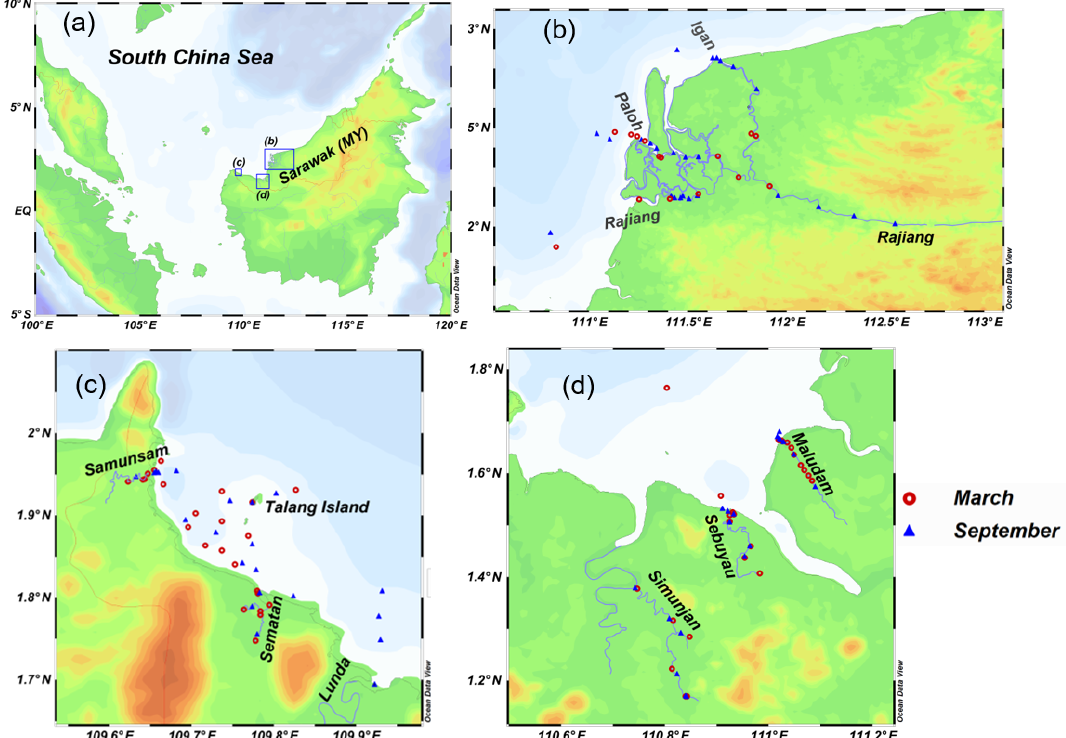
Figure 1. (a) Map of the study area showing the location of Sarawak on the island of Borneo. Blue boxes with letters indicate the areas shown in (b) – (d) . (b–d) Station locations for the Rajang River (b) ; the Samunsam, Sematan, and Lunda rivers (c) ; and the Maludam, Sebuyau, and Simunjan rivers (d) in March and September 2017. The maps were made with Ocean Data View